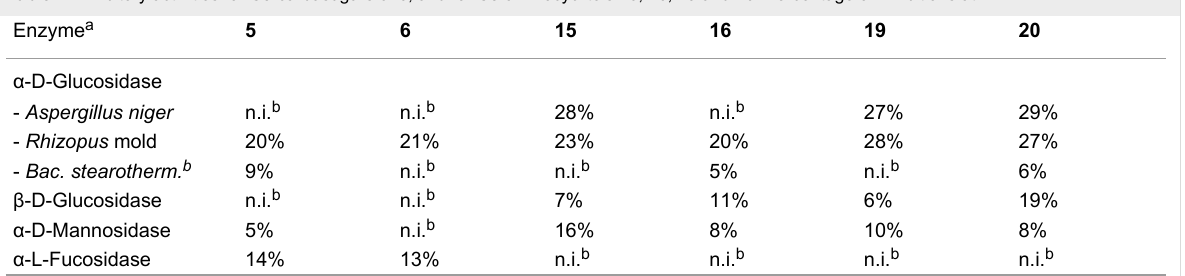
Table 2: Inhibitory activities for C8-carbasugars 5–6 , and for C8-aminocyclitols 15 , 16 , 19 and 20 . Percentage of inhibitions at 1 mM. Enzyme